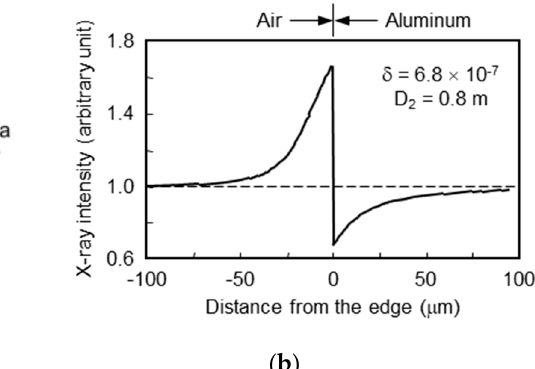
Figure 3. The CT setup with a phase-contrast effect at BL19B2 of SPring-8.